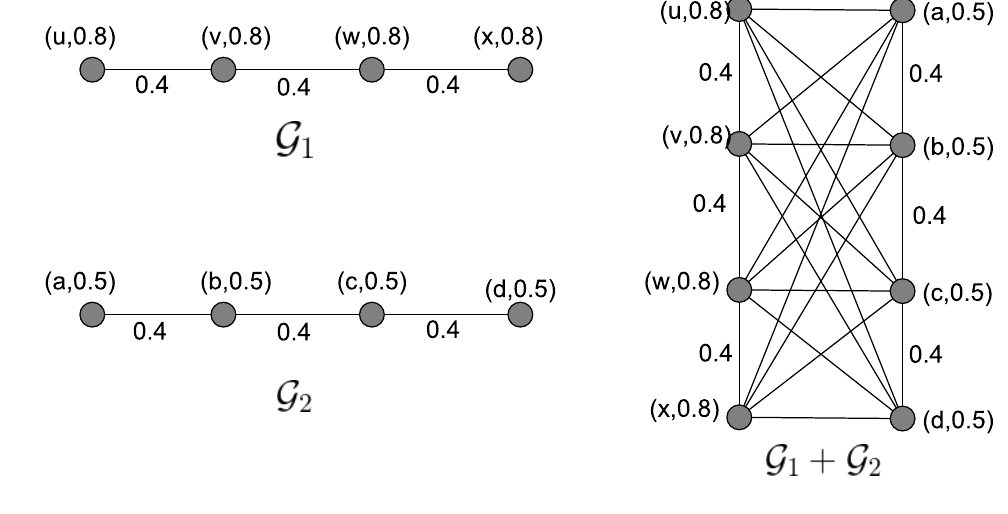
Figure 3: Fuzzy Graphs G